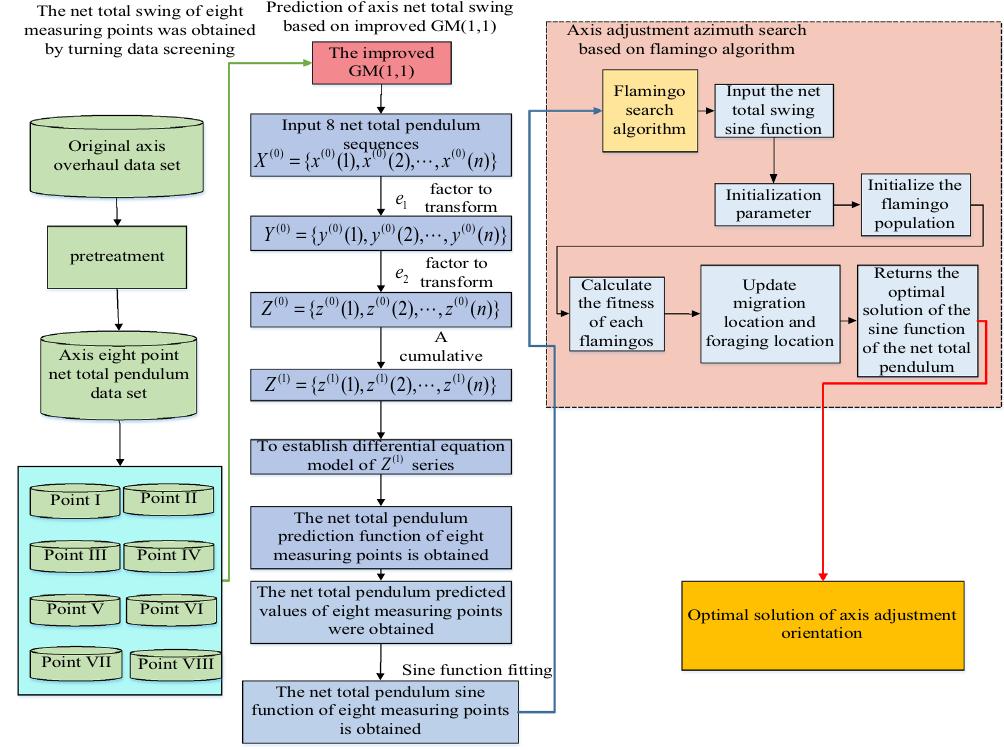
Figure 1. Framework diagram of the axial alignment